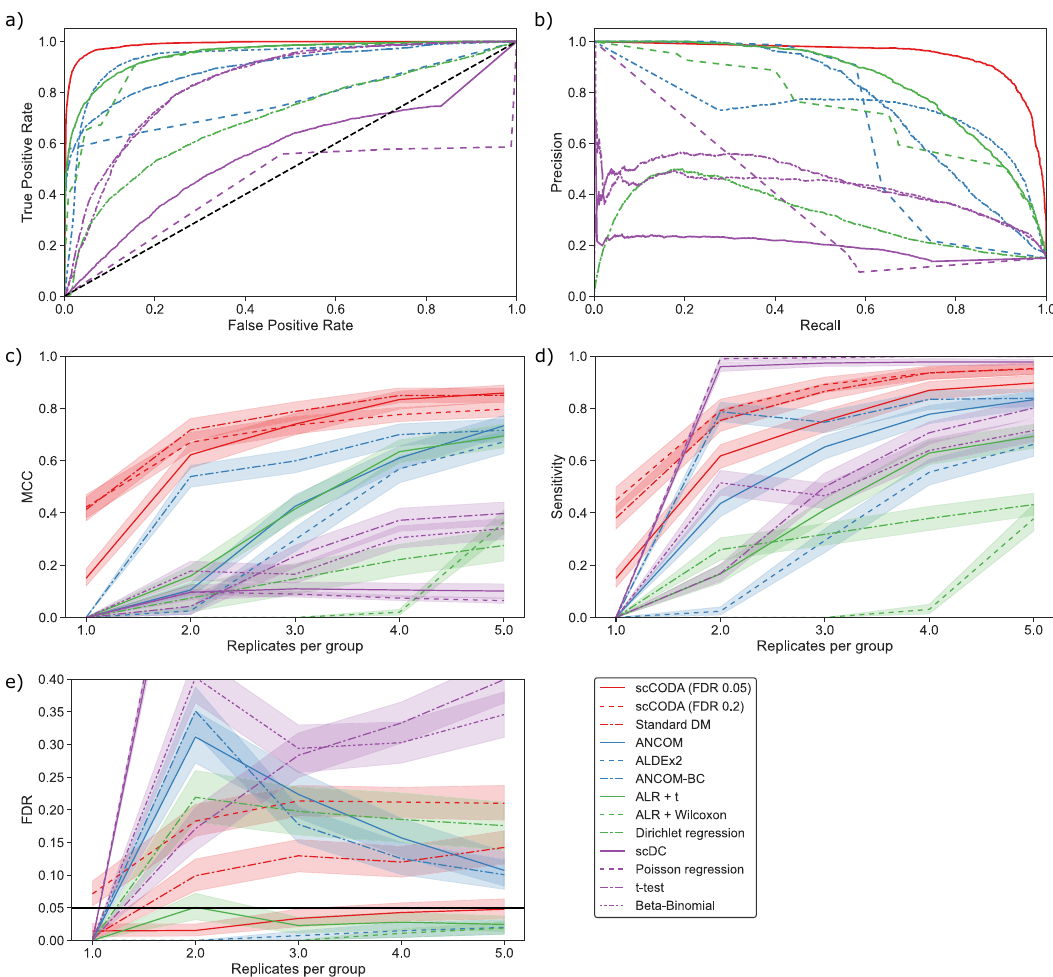
Fig. 2 Comparison of scCODA ’ s benchmark performance to other differential abundance testing methods. Bayesian models (red), non-standard compositional models (blue), compositional tests/regression (green), non-compositional methods (purple). Shaded areas represent 95% con fi dence intervals. a Receiver-operating curve ( n >1 samples per group). AUC scores are reported in (Supplementary Table 1) . b Precision-recall curve ( n >1 samples per group). Average precision scores are reported in (Supplementary Table 1) . c – e Performance metrics with increasing number of replicates per group over all tested scenarios. In the case of n = 1 sample per group, only Bayesian methods are applicable, other methods cannot detect any changes. c Overall performance measured by Matthews ’ correlation coef fi cient (MCC). d Sensitivity measured by true positive rate (TPR). e Precision measured by false discovery rate (FDR). The nominal FDR level of 0.05 for all methods (except scCODA with FDR 0.2) is indicated with a horizontal black